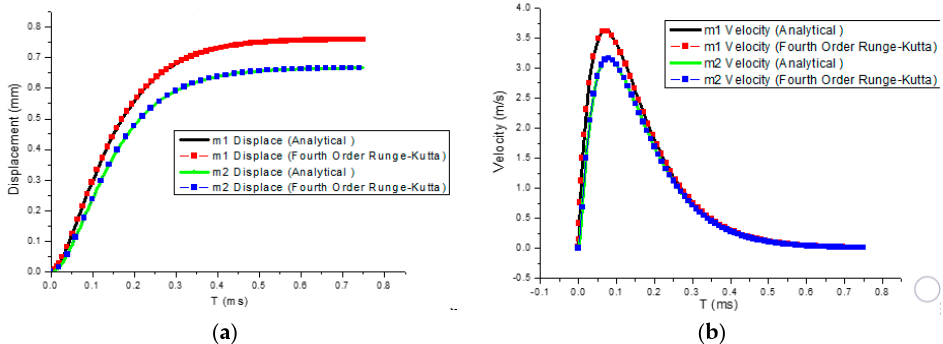
Figure 4. Comparison of analytical and numerical solutions for time histories of ( a ) the displacement and ( b ) the velocity of the two plates.